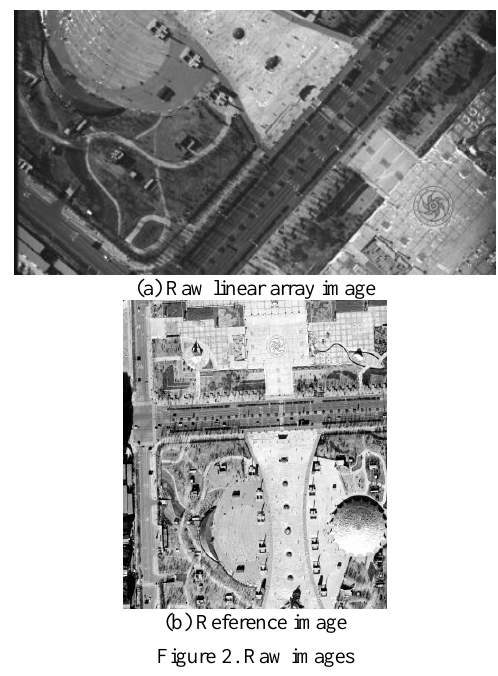
Figure 3 is the geometric rectification result only using POS data. Due to the presence of aircraft platform dither, the zebra crossing has been significantly distorted after